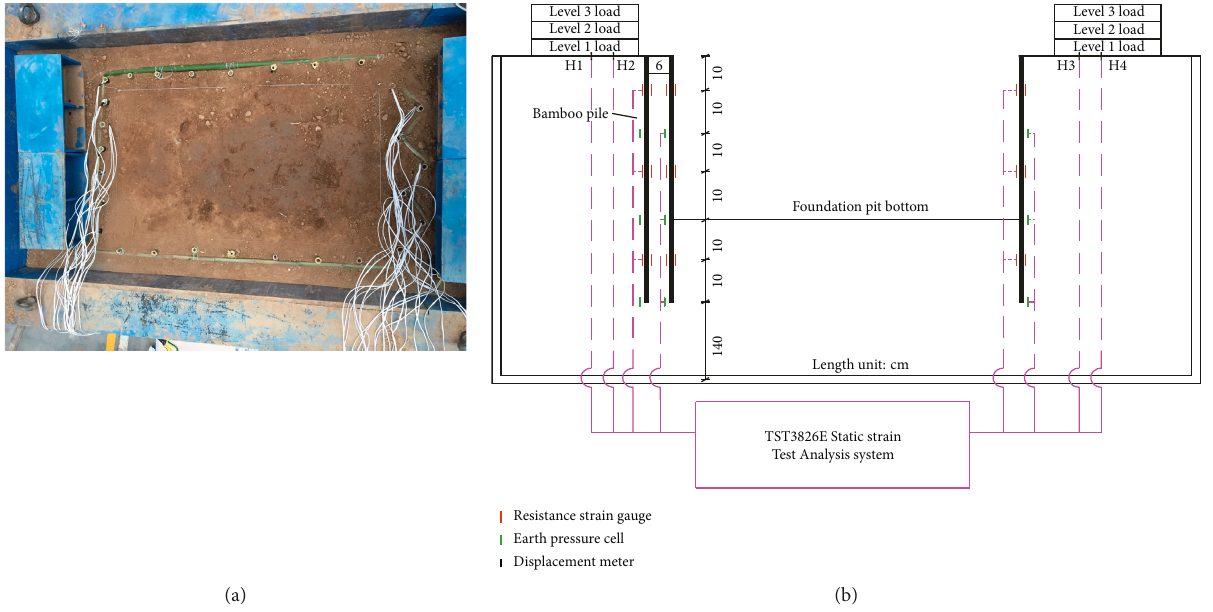
Figure 7: Mass loading. (a) Preloading in excavation stage, and (b) servo hydraulic control system.